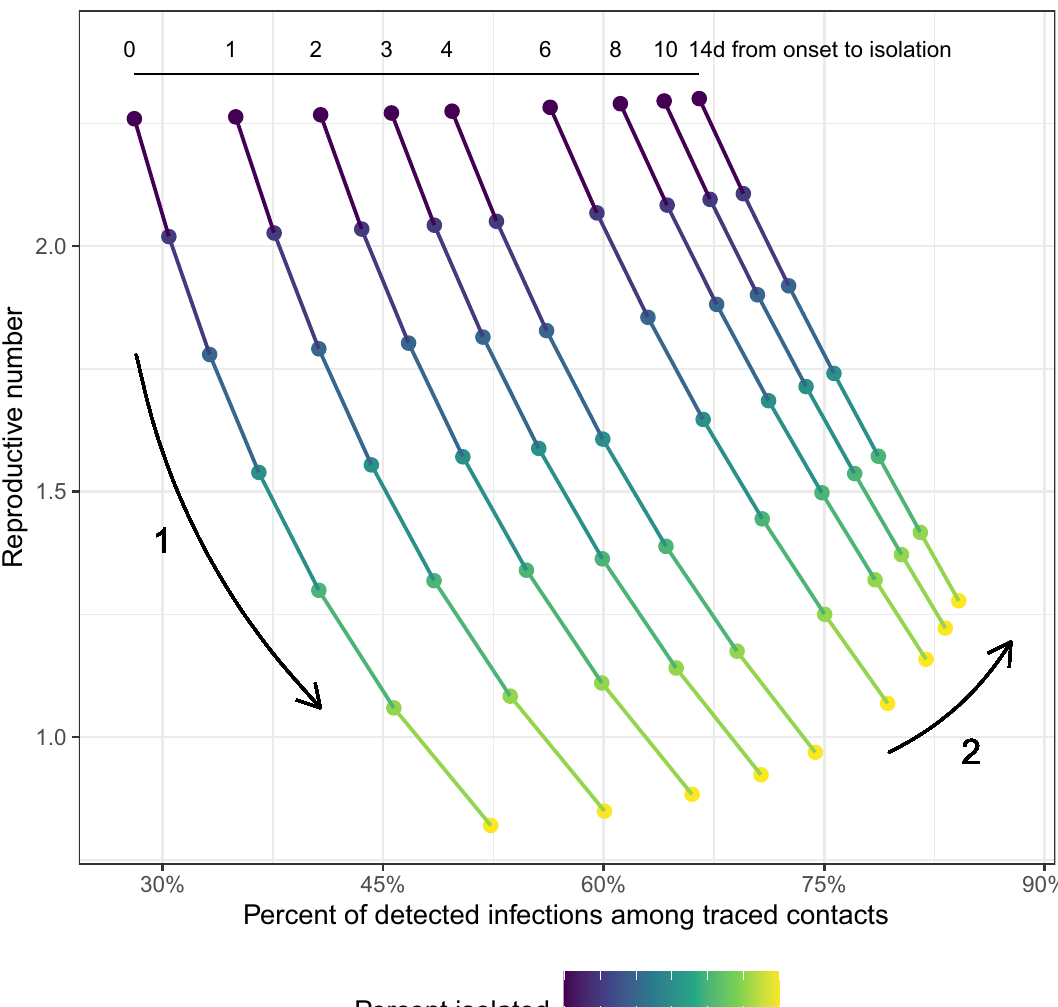
Fig 5. Relationship between R and the proportion of detected infections among traced contacts. Each position along a line shows a single test-trace-isolate strategy, with a fixed delay from case symptom onset to isolation (shown in the numbers at the top) and 90% of contacts quarantined on the same day as case isolation. Points are colored by the proportion of infections detected and isolated through testing. When isolation timing remains constant, higher case isolation completeness corresponds with increases in the proportion of detected infections among traced contacts and reductions in R (Arrow 1). However, increases in the proportion of detected infections among traced contacts could indicate an increase in R , if the delay to case isolation is also increasing, thus leading to more secondary cases among traced contacts (Arrow